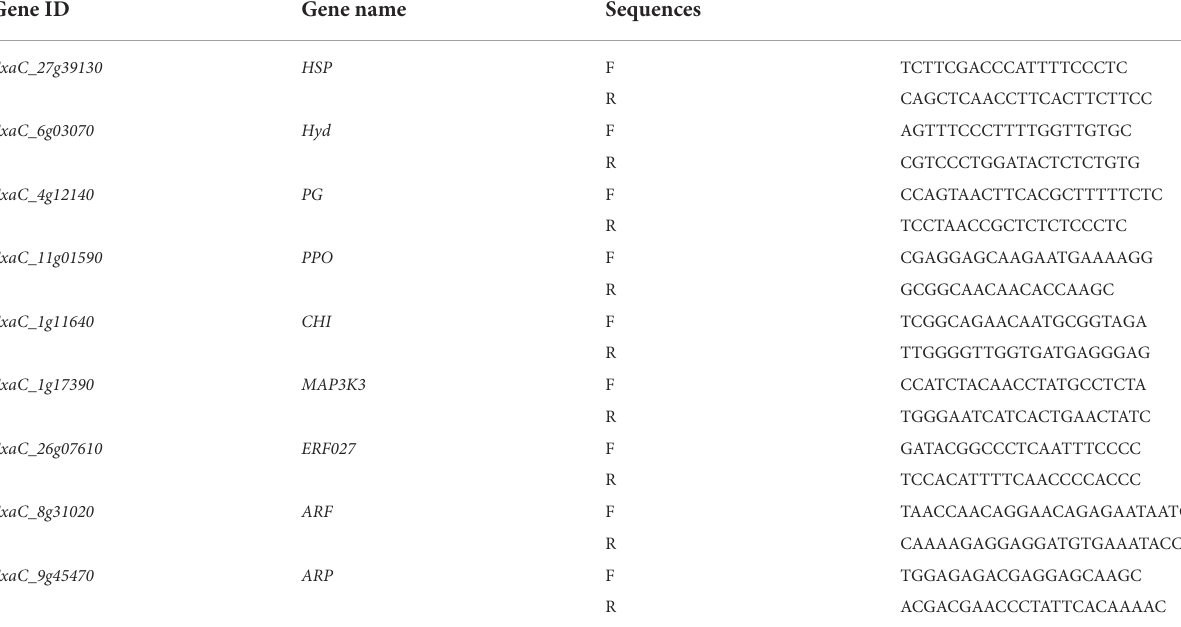
Table A1 Primers used for qRT-PCR in strawberry